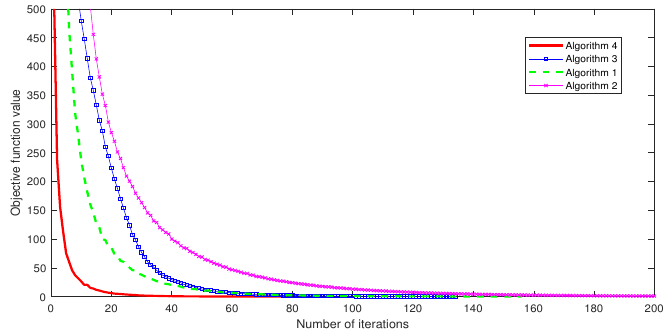
Figure 3. The objective function value versus number of iterations when N = 1024, M = 512 and κ = 10 − 5 .